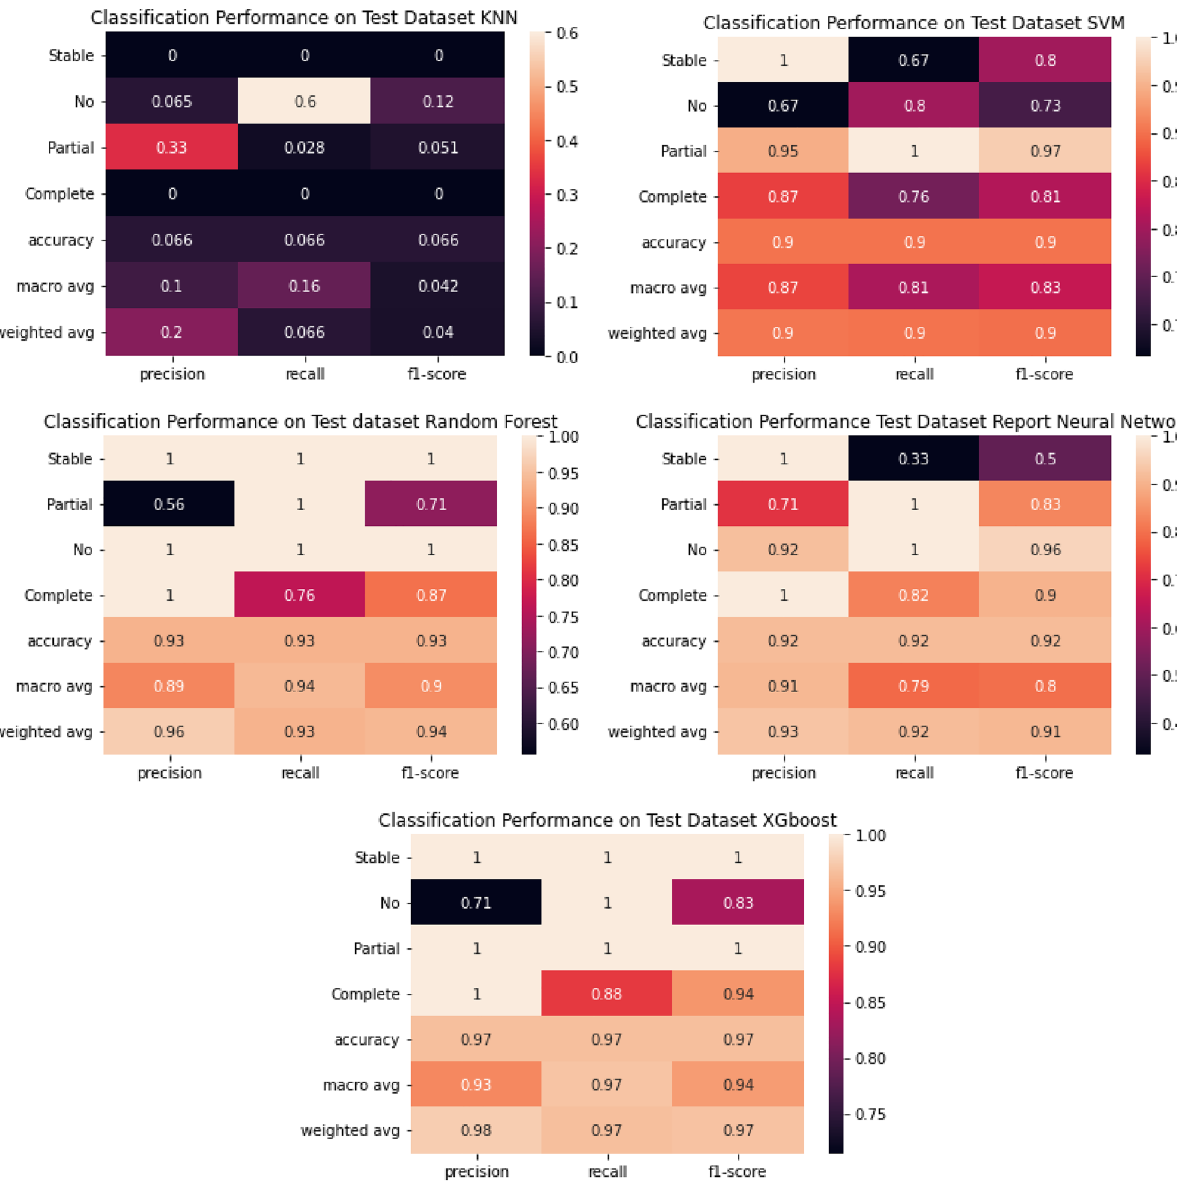
Figure 8. Classification performance on testing dataset.